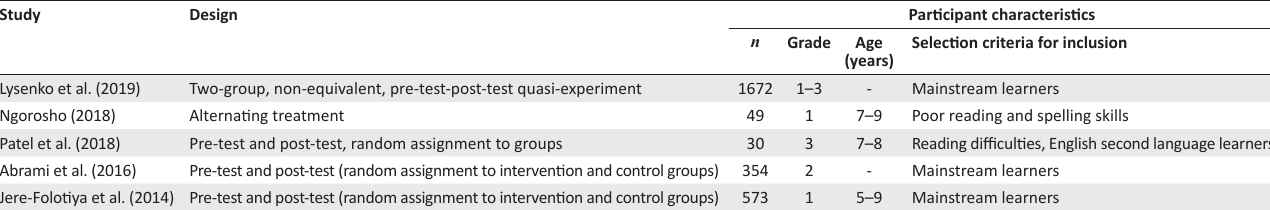
TABLE 2: Information and communication technology studies carried out in the majority world – An overview based on a subset of the main scoping review.